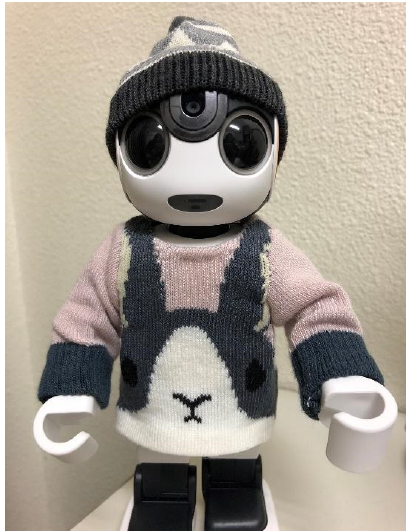
Figure 6 . Robohon owned by the first author (Source: Photograph taken by the authors). Figure 6. Robohon owned by the first author (Source: Photograph taken by the